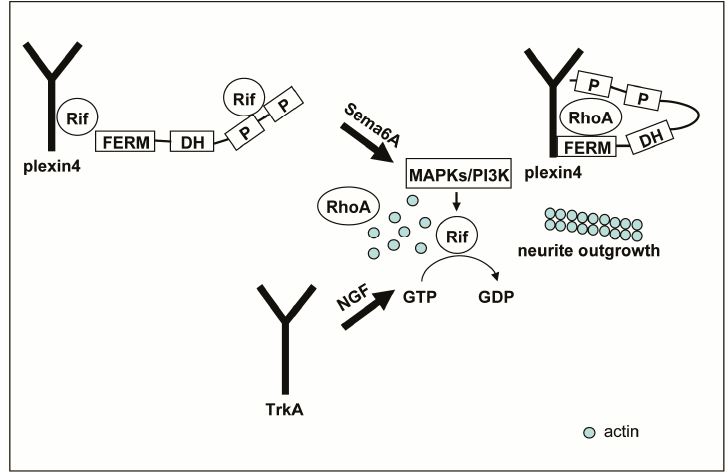
Figure 6. The role of Rif in neurotrophin-induced neurite formation in PC12 cells. In the absence of neurotrophin, the cells are maintained in a steady state and Rif protein exists in its highly activated form in the plasma membrane. When cells are stimulated with neurotrophin, MAPK and PI3K signaling pathways are activated, leading to decreased Rif activation. Sema6A and NGF activated signaling pathways could work individually or cooperatively by regulating downstream MAPKs/PI3K, to stimulate neurite outgrowth in PC12 cells.